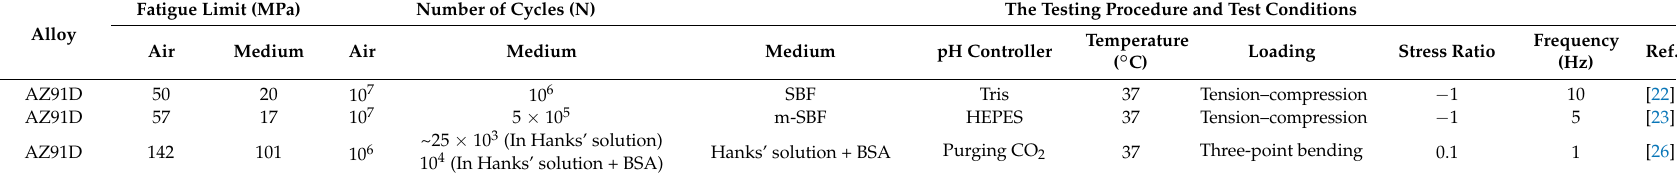
Table 2. Comparison of fatigue limits and experimental set-ups employed for evaluation of the fatigue life of a common Al-containing Mg alloy in different pseudo-physiological